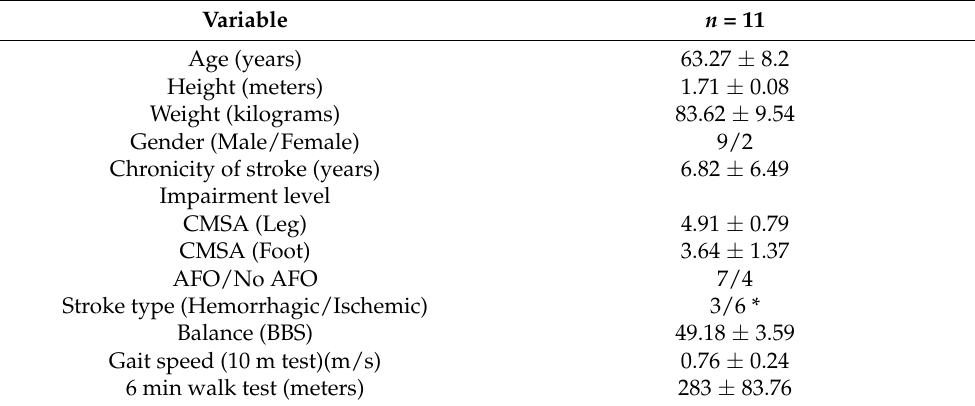
Table 1. Demographics and clinical outcome measures for study